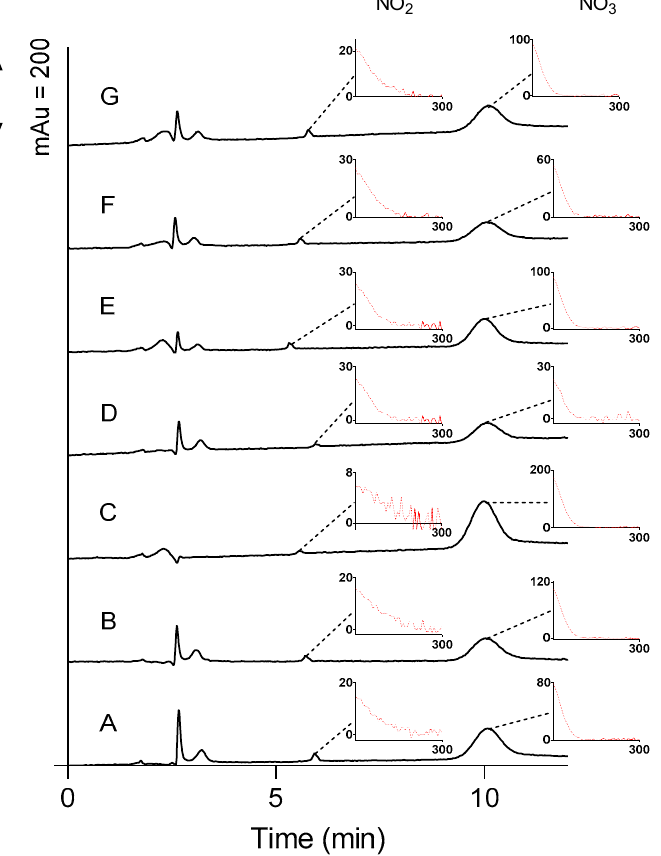
Figure 5. Chromatograms and spectra obtained at maximum of each chromatographic peak for several waters by IT − SPME − IE − CapLC − DAD. Natural water: well (trace G), river (trace F), and lake (trace E) diluted 1/40, 1/50 and 1/500, respectively, drinking water: tap (trace D) diluted 1/50 and undiluted bottled (trace C) and water treatment plant: inlet (trace A) and outlet (trace B), both diluted 1/50. The retention times for nitrite and nitrate are 5.8 and 10.5 min, respectively.